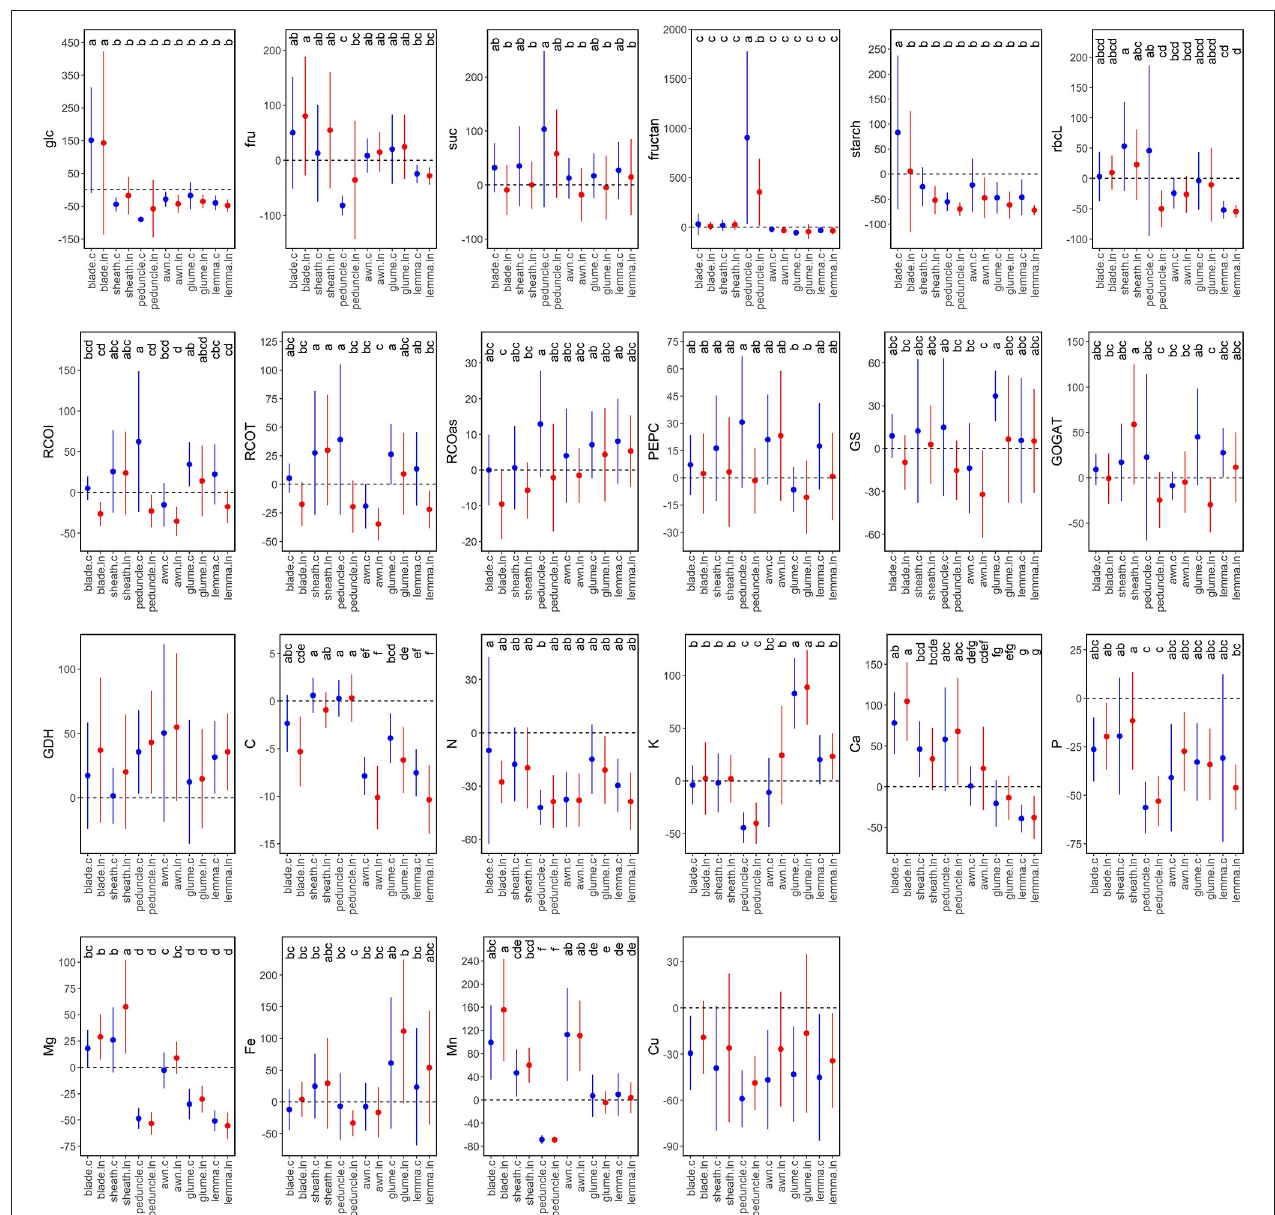
FIGURE 7 | Percentage (%) of variation between anthesis (Zadoks 65, blue) and mid-grain filling (Zadoks 75, red) for the metabolite contents, Rubisco large subunit protein, enzyme activities, and nutrient contents. Each dot is the average of four field-grown durum wheat varieties per organ (blade, sheath, peduncle, awn, glume, and lemma) and N supply (c, control; ln, low N). The different letters differ statistically ( p < 0.05). The abbreviations are described in Supplementary Table 1 .